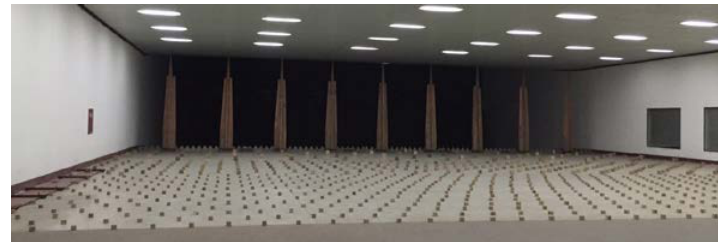
Figure 4. Spire turbulence field installed in XNJD-3 wind tunnel.